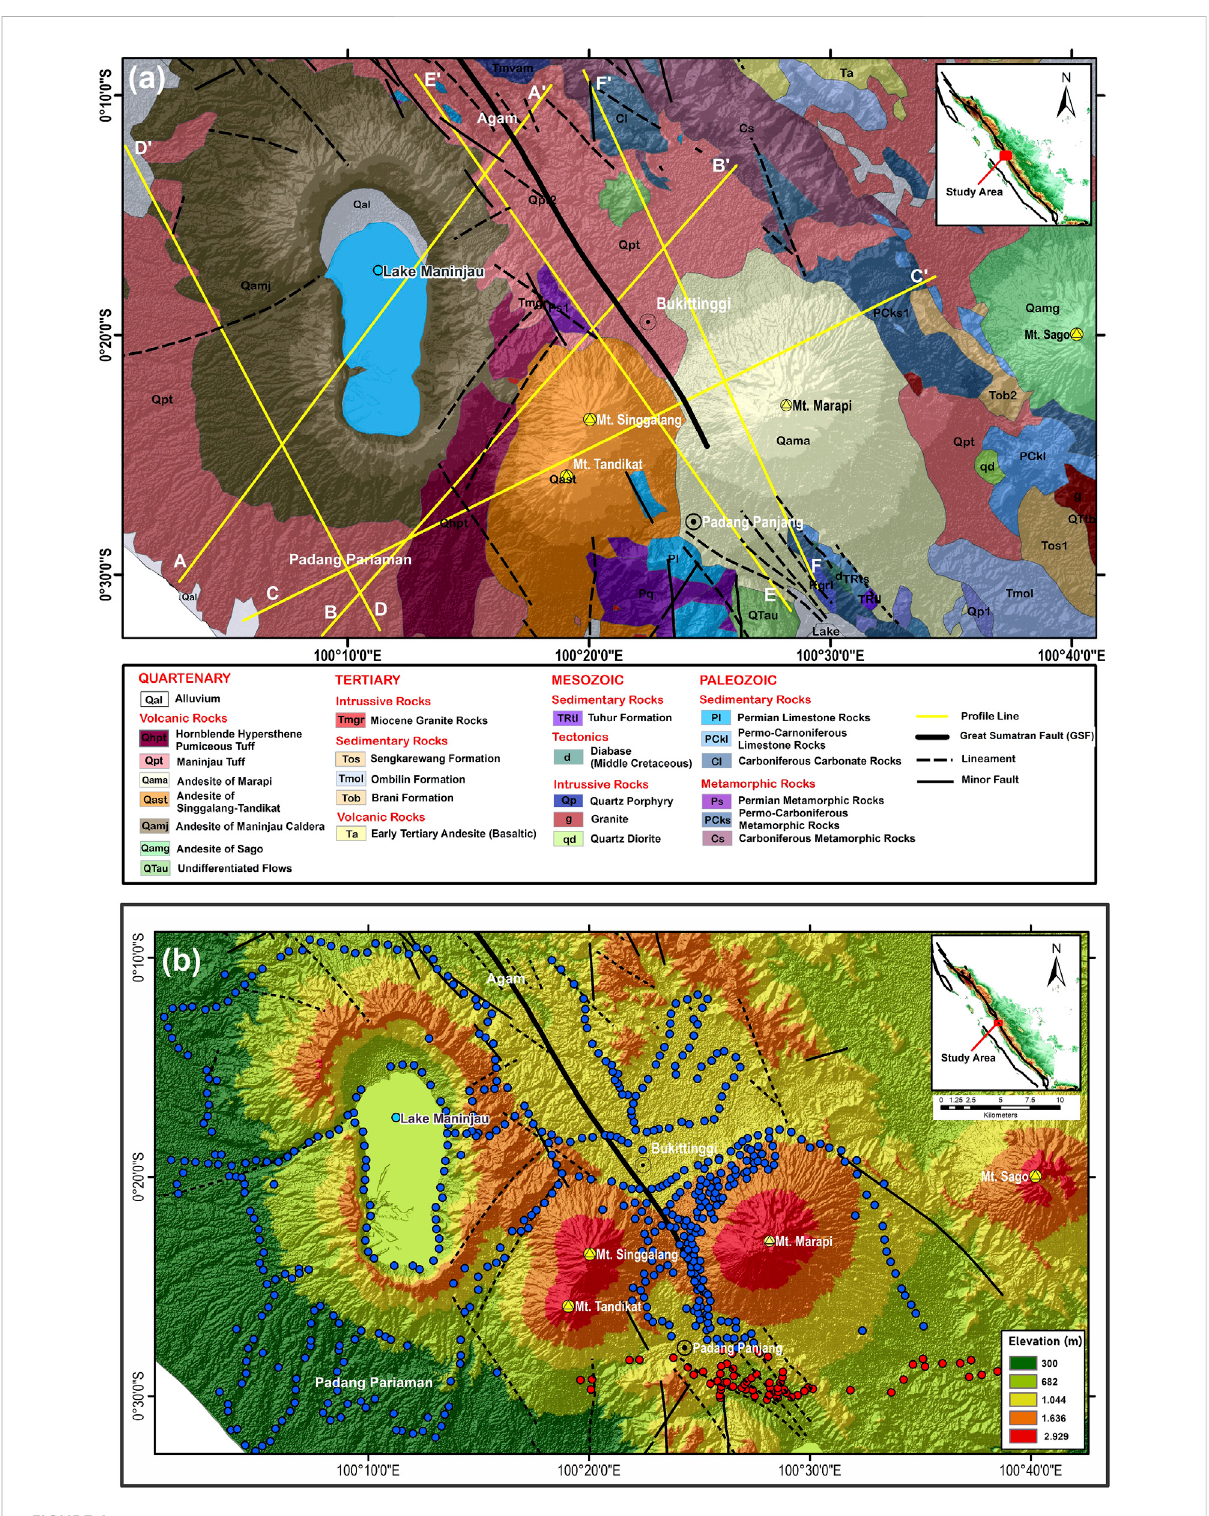
FIGURE 1 (A) Geologicalmap oftheSianok segment ofGSF showingthefault line,lithologiesinthestudy area (modi fi edfromKastowo et al.,1996 and by Silitonga and Kastowo, 1995), and the six pro fi les (A-A ′ , B-B ′ , C-C ′ , D-D ′ , E-E ′ , and F-F ′ ) shown as thick yellow lines; (B) topographic map of the Sianok segment, including magnetic survey point locations along existing roads and dirt roads. Certain areas, especially near the volcanoes, are not accessible due to their terrain. Blue circles are new survey points, while red survey points were from Amir et al.